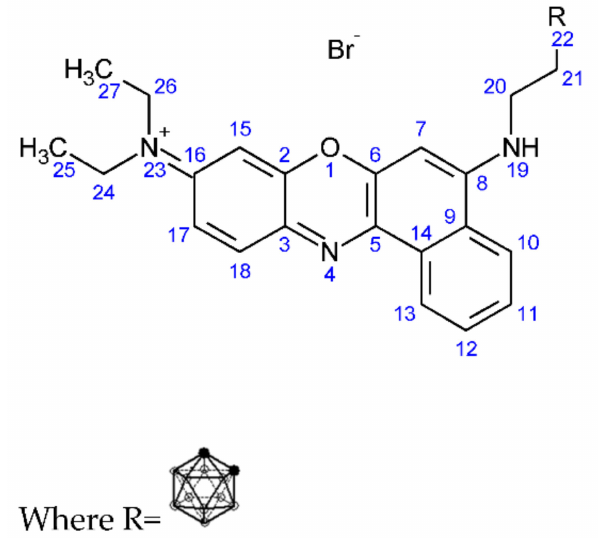
Figure 7. Structure of (3-carboranylpropyl)-(N 9 ,N 9 -diethyl-9H-benzo[ a ]phenoxazine-5,9-diamine) bromide (4).